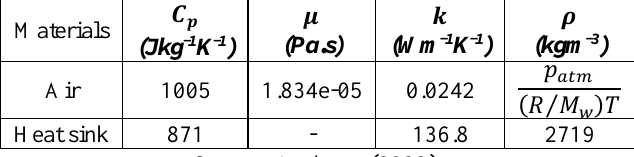
Table 3: Thermo-physical properties of the heat sink and the air.